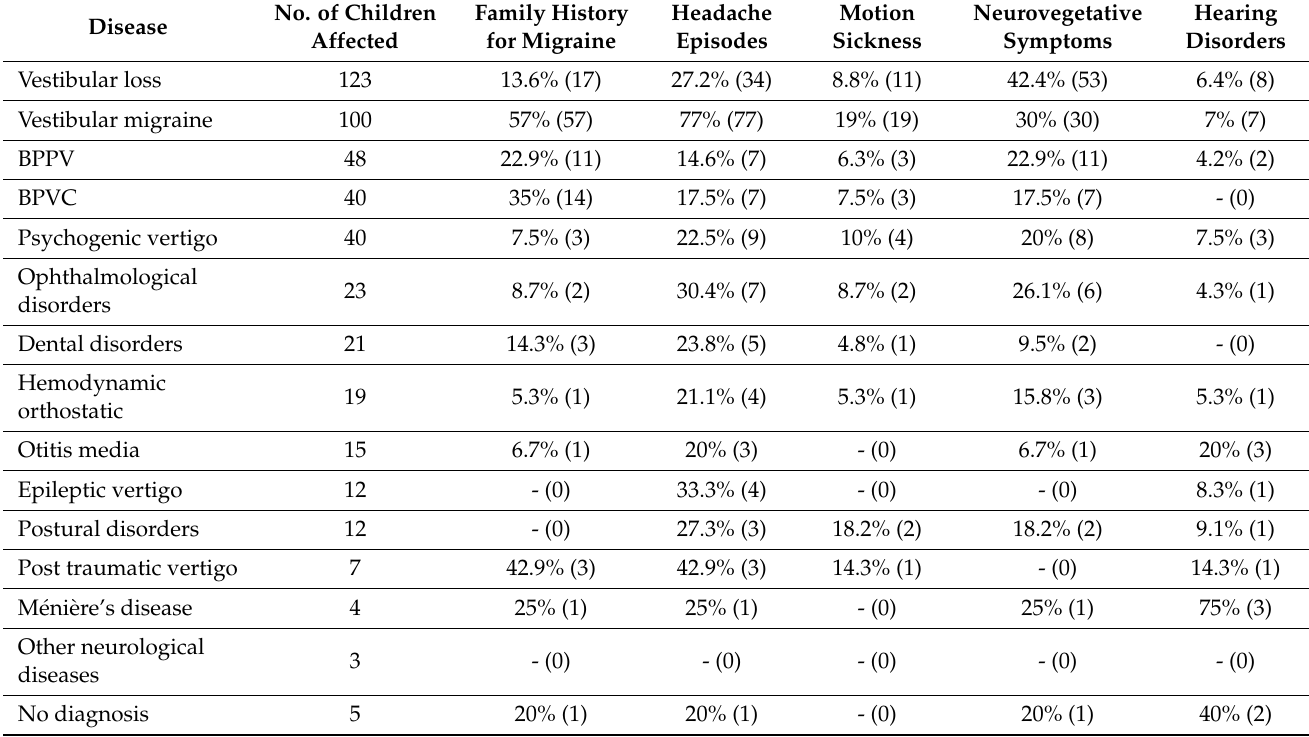
Table 2. Family history of migraine and distribution of symptoms according to cause of vertigo in children (No. of children with positive